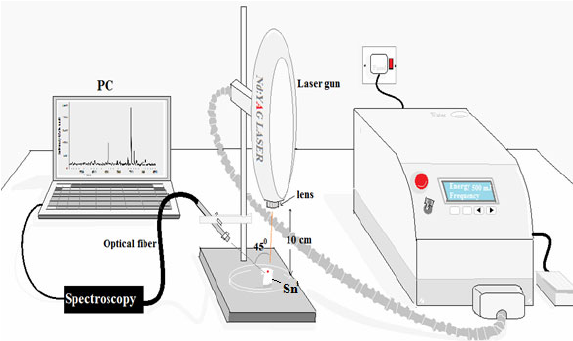
Fig. 1 Conventional LIBS system configuration used in this work.